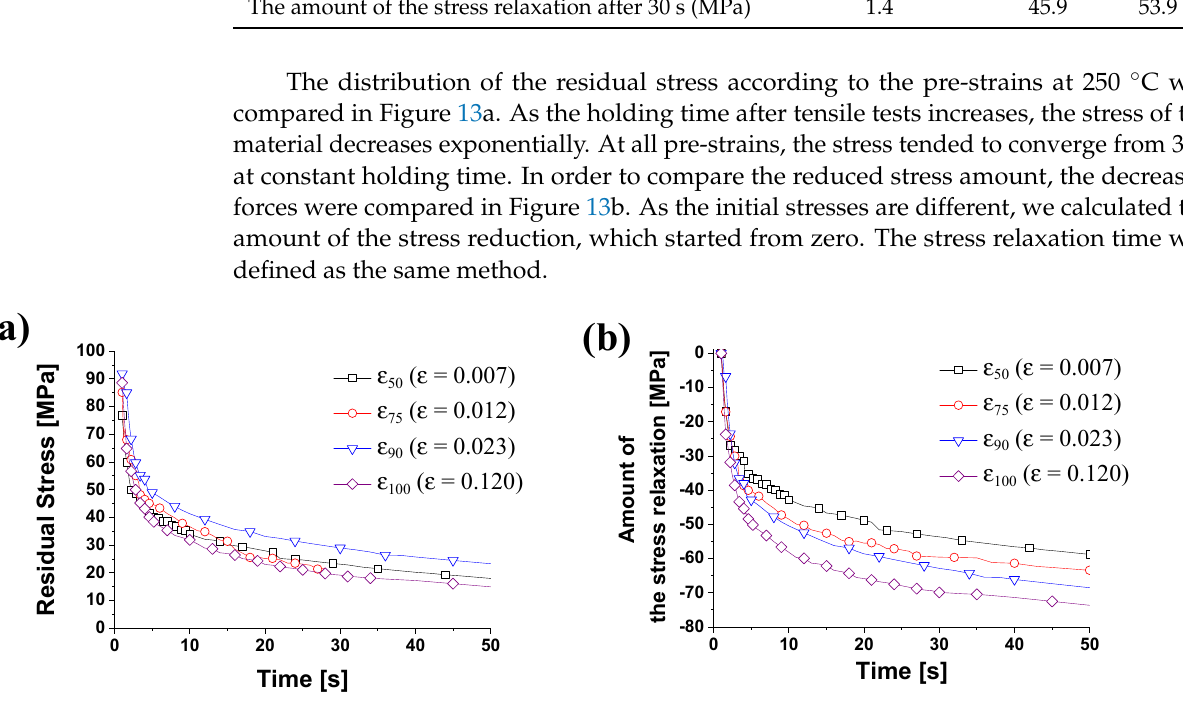
Figure 13. The stress relaxation at 250 °C with different pre-strain values; ( a ) residual stress and ( b ) amount of the stress relaxation.